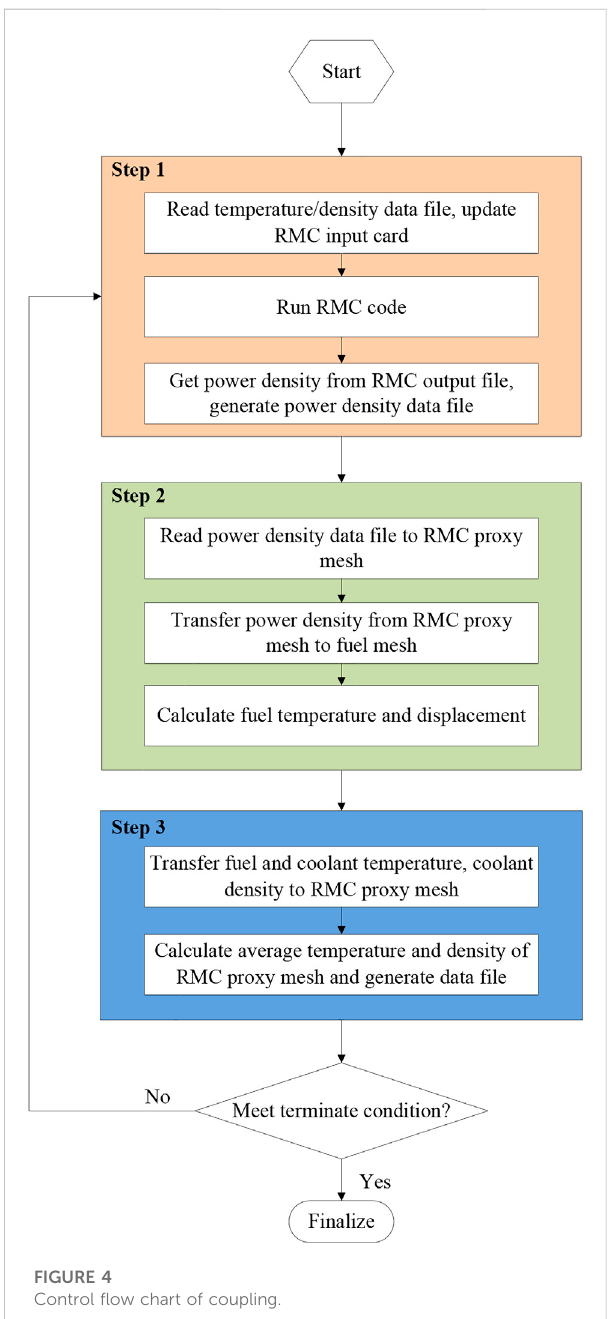
FIGURE 4 Control fl ow chart of coupling.